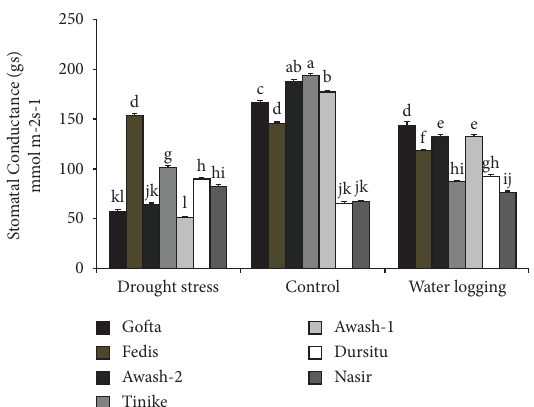
Figure 1: Interaction efect of common bean varieties and soil irrigation interval on stomatal conductance under lath house,